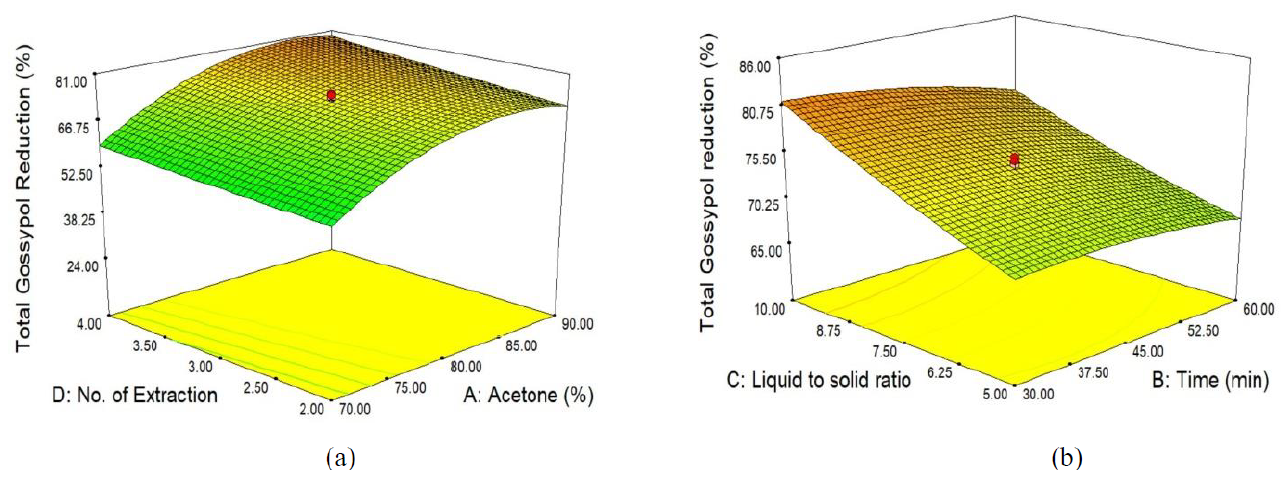
Figure 9. ( a ) 3D surface plot no. of extraction cycles and acetone % ( b ) 3D surface plot between LSR and time of extraction %.